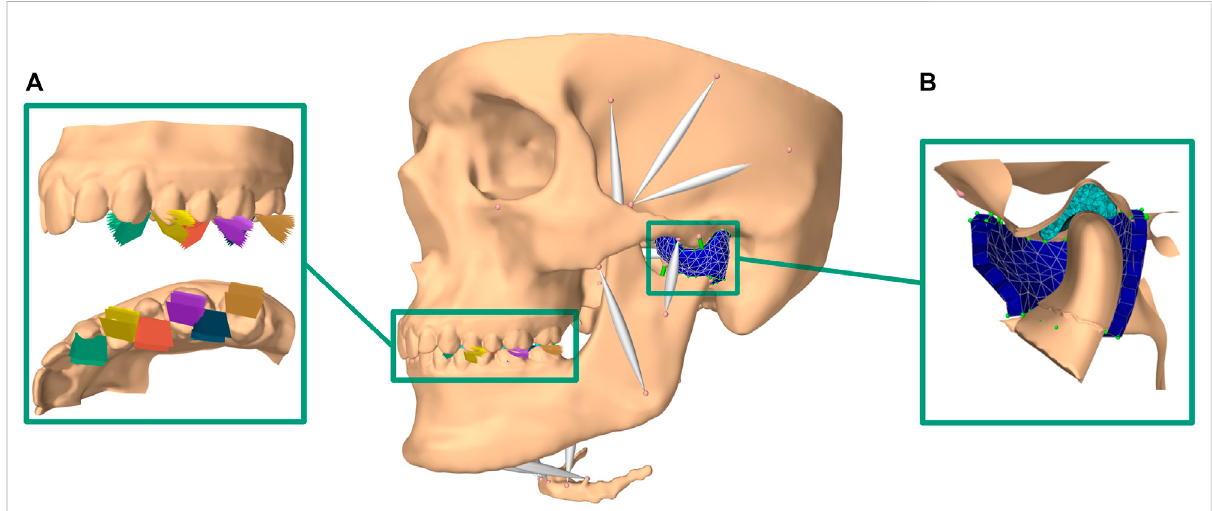
FIGURE 1 Overviewofmodelingset-up; (A) bruxingpositionsandinclinationsincluded(brown:LTonsecond molar,blue:MTonsecond molar;violet:LT on fi rst molar; red: MT on fi rst molar; yellow: LT on fi rst premolar; green: MT on fi rst premolar)); (B) cut through the improved TMJ model using a FE TMJ